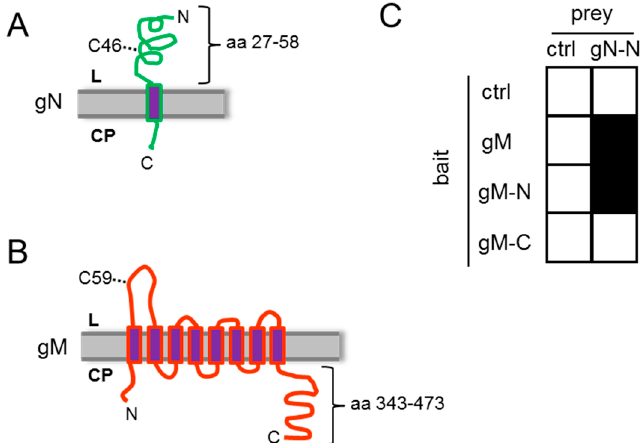
Figure 1. HSV-1 gN and gM interact via their N-terminal domains. ( A ) The schematic figure shows the putative localization of HSV-1 gN within cellular membranes. The N-terminal domain faces the luminal (L) side and the C-terminal domain is exposed on the cytoplasmic (CP) side, with a membrane anchor domain near the C terminus (CBS SignalP and TMHMM Server were used for prediction); ( B ) HSV-1 gM is a membrane protein encoding 8 predicted membrane domains with both N- and C-terminal domains exposed to the cytoplasm; ( C ) the interacting domains of gM with gN were analyzed by applying the yeast-2-hybrid system. Yeast cells expressing either full-length gM or gM 1–342 (gM–N) fused to Gal4–DBD together with Gal4–AD-coupled N-terminal domain of gN 27–58 (gN–N) were able to grow on medium selective for reporter gene activity, while the cytoplasmic tail of gM 343–473 (gM–C) failed to interact. As a control (ctrl) empty bait and prey plasmids were used.